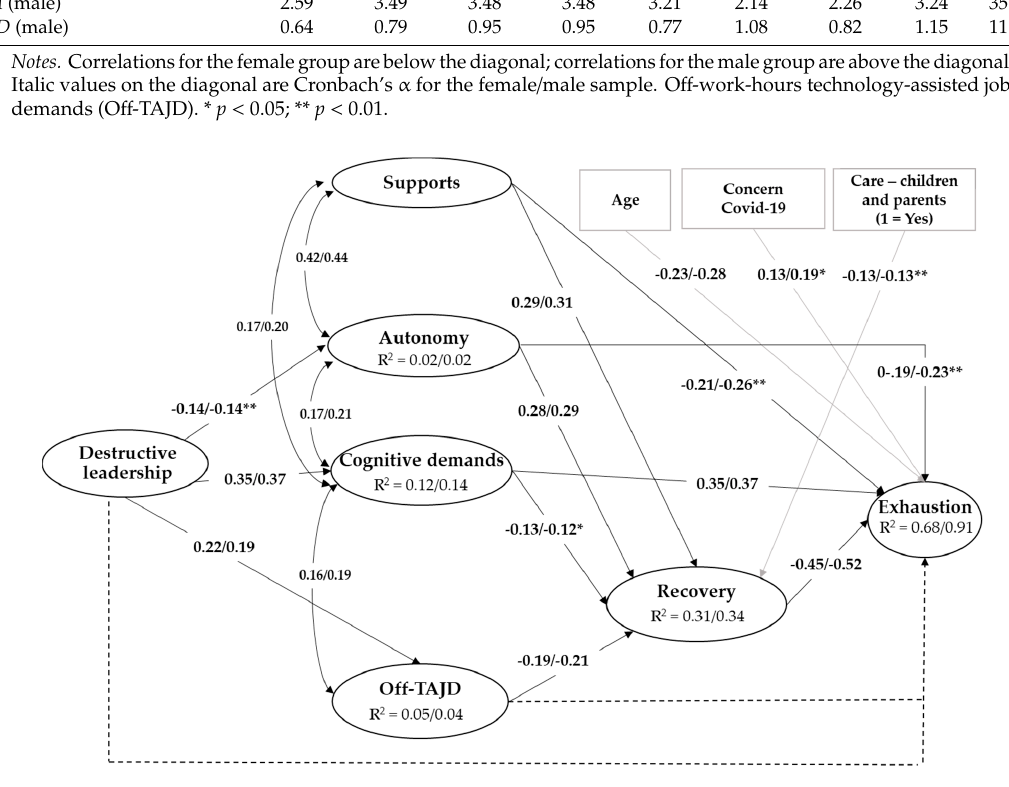
Figure 2. The tested multi-group structural equation model (MG-SEM) (standardized path coe ffi cients; p < 0.001; ** p < 0.01, * p < 0.05). Discontinuous lines indicate non-significant relationships. Off-work-hours technology-assisted job demands (O ff